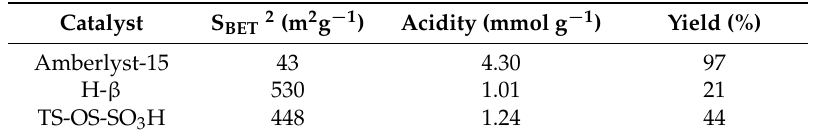
Table 1. Condensation reaction of resorcinol with ethyl acetoacetate using various heterogeneous solid acids catalysts 1 .